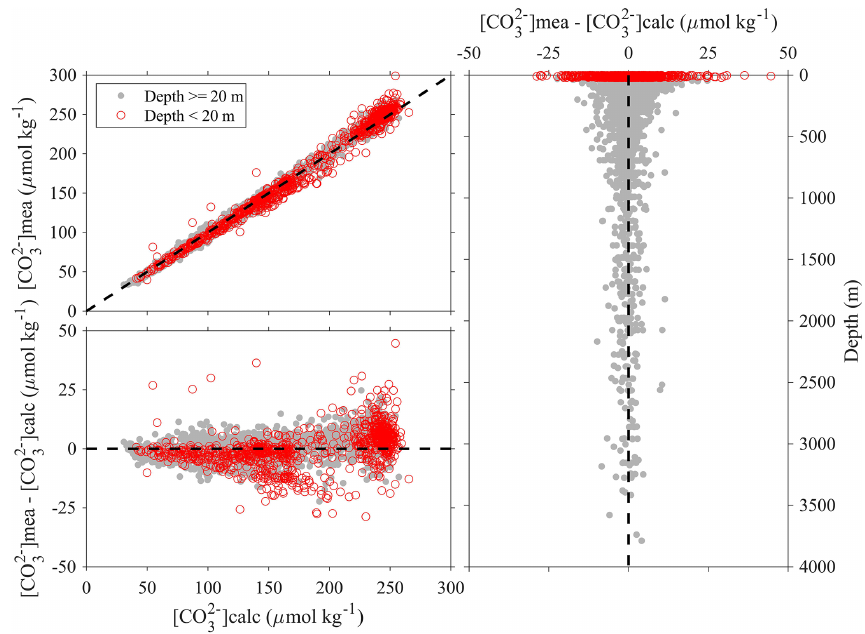
− ]mea) and that is calculated 3